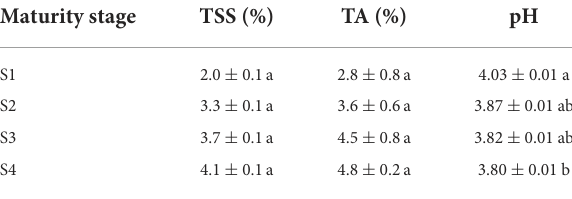
TABLE 1 Total soluble solid, titratable acidity, and pH value of Kakadu plum fruit at different maturity stages. Maturity